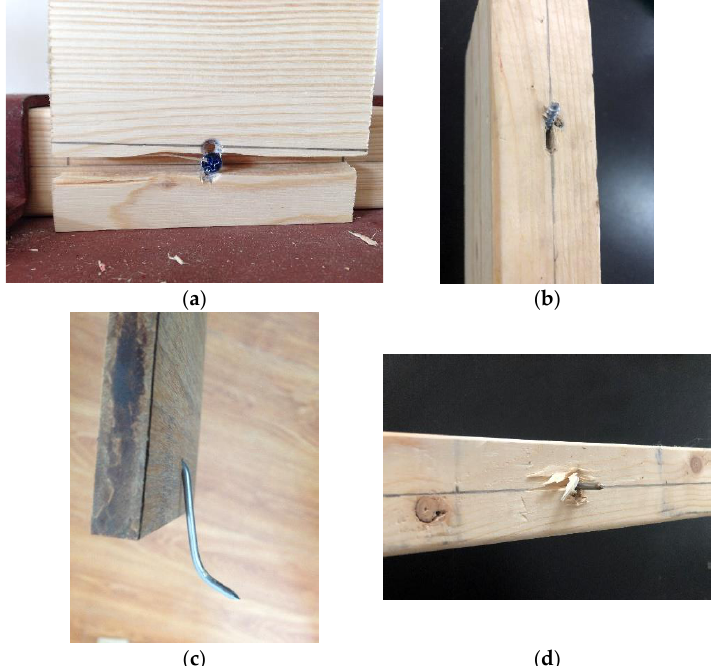
Figure 4. Failure modes of the joints: ( a ) Brittle failure of SPF sheathing panel, ( b ) Brittle failure of screw, ( c ) Bending of nail, ( d ) Fatigue break of